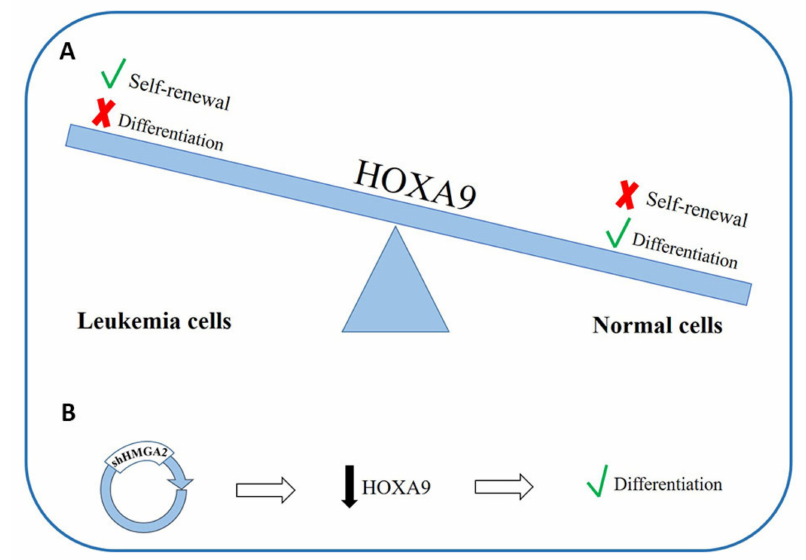
Figure 3. The role of HOXA9 regulation in normal myeloid di ff erentiation: ( A ) HOXA9 overexpression maintains the self-renewal capacity of leukemic stem cells and blocks the di ff erentiation process. ( B ) In some leukemia cell lines, HMGA2 knockdown a ff ects HOXA9 expression, and this influences the di ff erentiation processes in myeloid cells. HOXA9-Homeobox A9; HMGA2-High mobility group AT-Hook